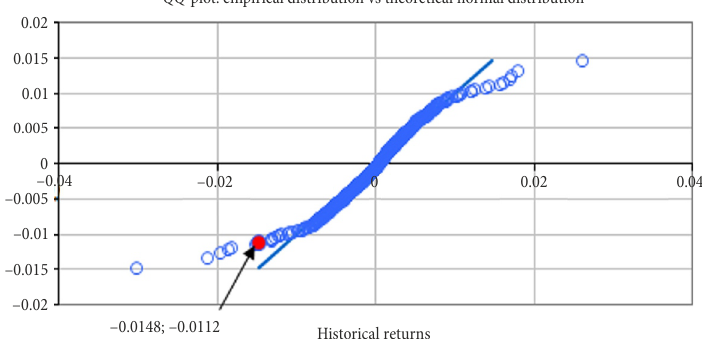
QQ-plot: empirical distribution vs theoretical normal